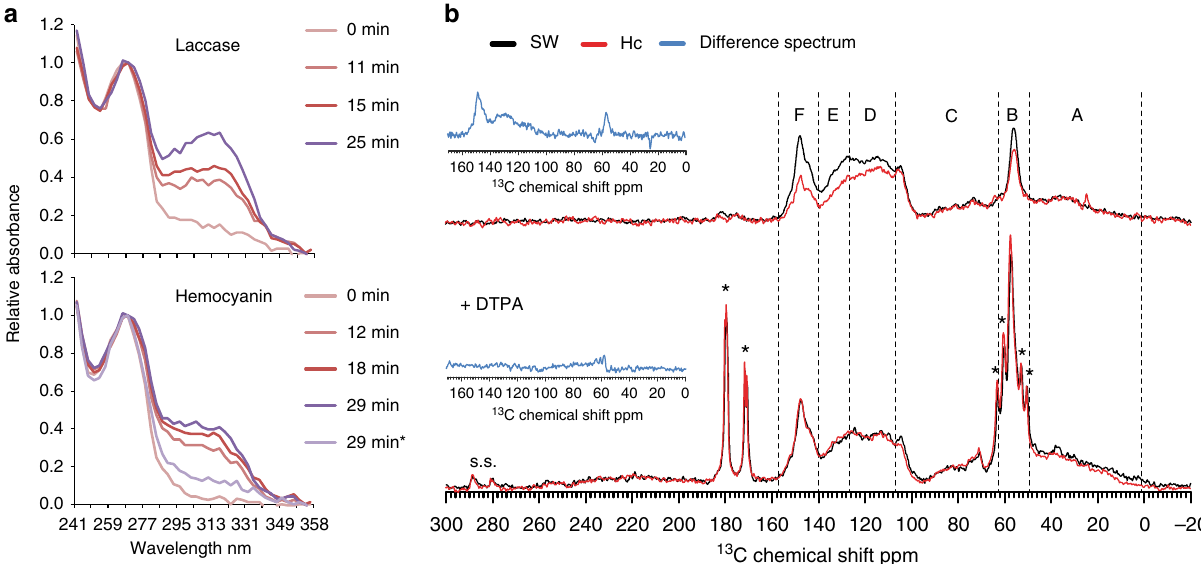
Fig. 4 Hemocyanin activity on pyrogallol and isolated lignin. a UV-Vis spectra of Trametes versicolor laccase compared with activated (by addition of 2.75 m M SDS) hemocyanin in 0.1 M NaPO 4 pH 6.8 with 1 m M pyrogallol during incubation at room temperature for the time indicated (min; darker tones with increasing time). Asterisk * indicates spectrum for hemocyanin incubation without SDS addition (no activation, light purple). Absorbance maximum of pyrogallol at 267 nm and of oxidation product purpurogallin at ∼ 320 nm. b 13 C solid-state NMR spectra of alkali lignin (3%) after 1 h incubation in seawater (SW, black) or with hemocyanin (Hc, red), top panel: activated Hc, bottom panel: Hc inhibited with chelator (50 m M diethylene triamine penta- acetic acid, DTPA). The spectra were normalized to match the signal of aliphatic (10 – 60 ppm) and O-aliphatic carbons (60 – 110 ppm) of lignin. The spectral regions delimitated by capital letters correspond to: A — aliphatic carbons of lignin. The sharp peak at 24.9 ppm is characteristic for CH 3 /CH 2